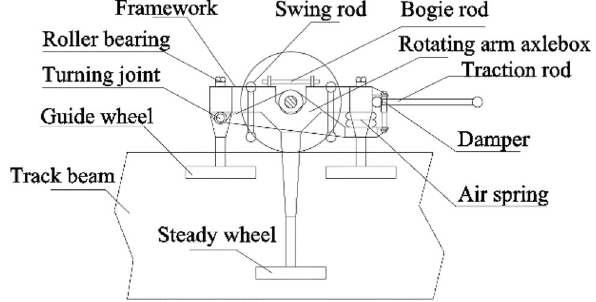
Fig. 5 Schematic diagram of the suspension structure